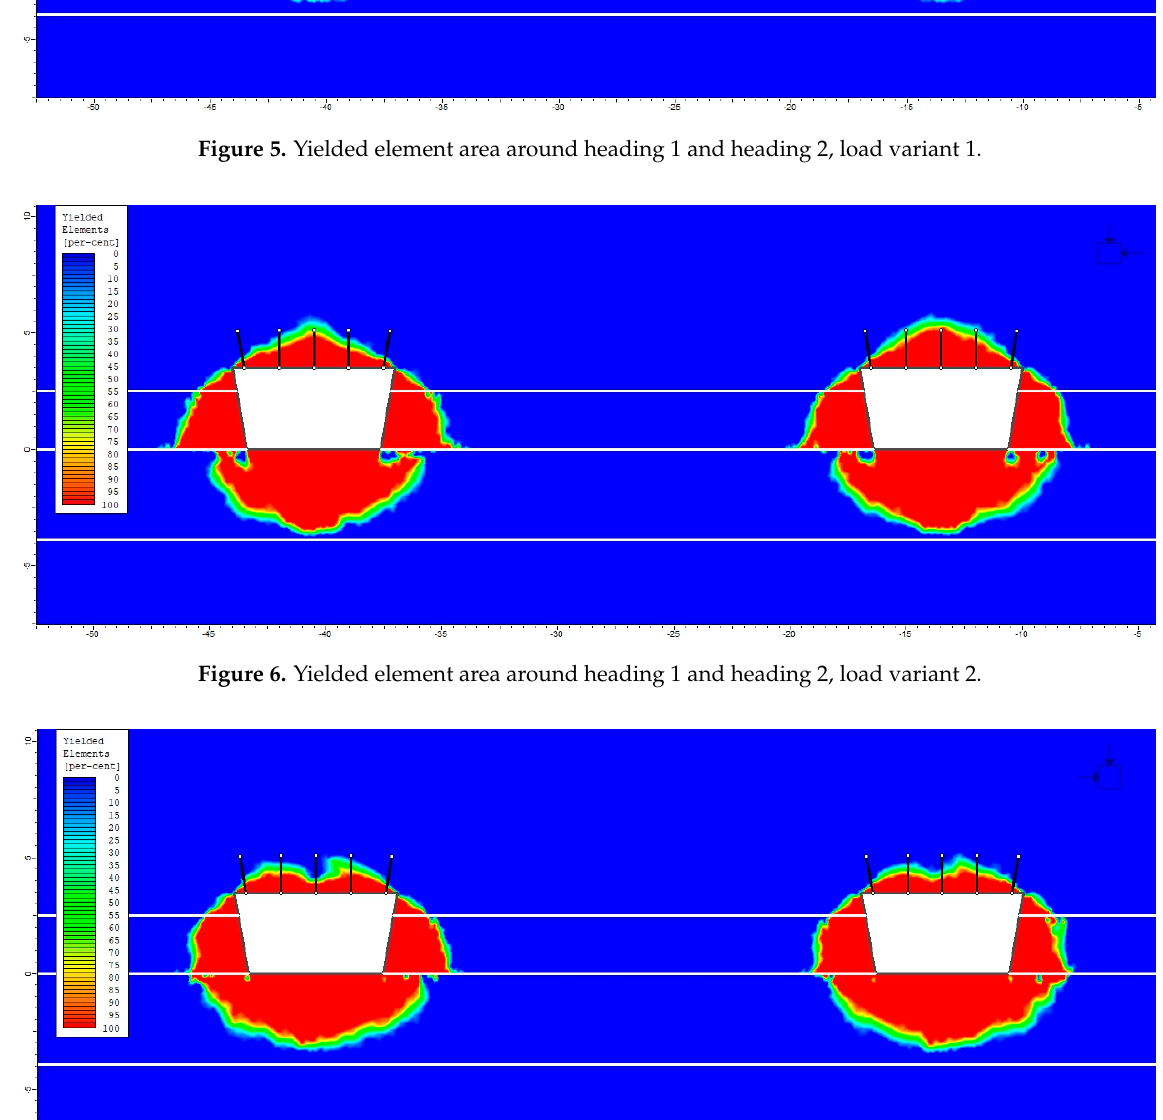
Figure 8. Yielded element area around heading – 3 and heading – 4, load variant – 2. Table 6 lists the range of yielded rock mass (yield between 50% and 100%) in the roofs of the analyzed headings. For the assumed geological and mining conditions of the Pol- kowice-Sieroszowice mine, the simulated change of direction in which the heading group is driven resulted in an increased yielded zone in the roofs within the range of 0.45 ÷ 0.58 m, which translates into an increase by 34.09% to 42.65%, respectively. The maximum range of yielded rock mass in the roofs of the headings driven in perpendicular to the direction of the maximum horizontal stress component σ H (load variant 2) was greater than the bolted zone of 1.6 m. The excavations may suffer from the loss of roof stability (collapse of the immediate roof in the excavation). Table 6. List of the yielded rock mass range in the roofs of the analyzed headings (yield between 50% and 100%). Excavation